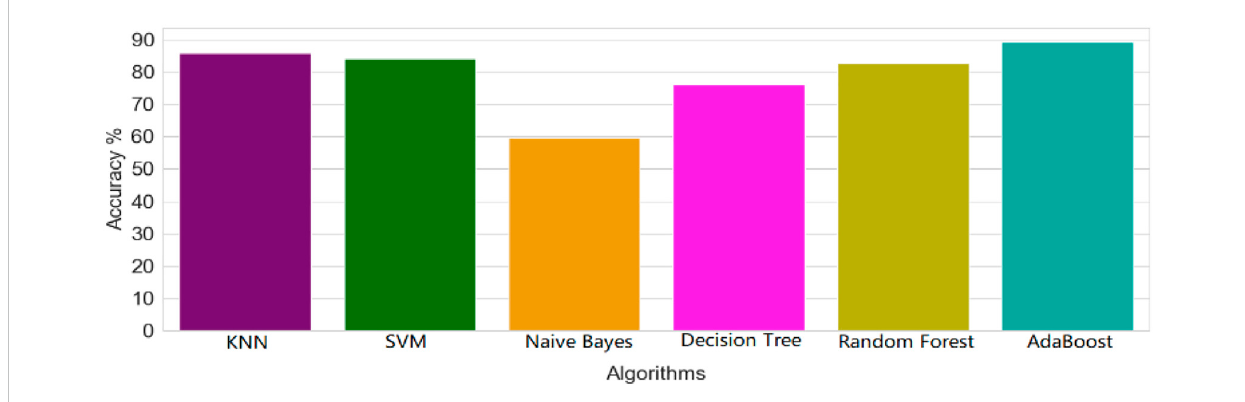
FIGURE 7 Accuracy comparison of different classi fi ers.